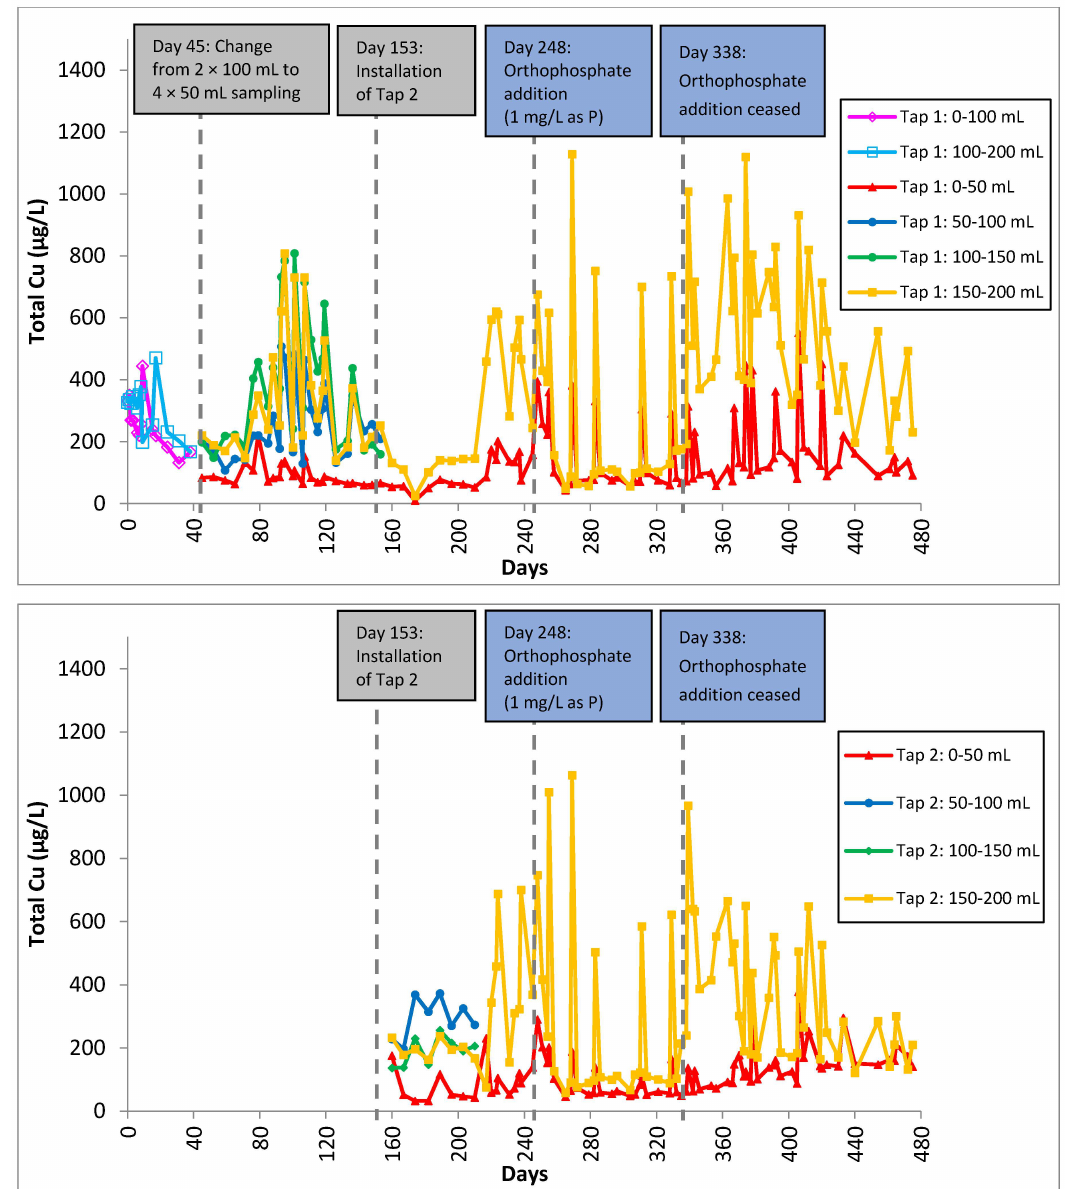
Figure 4. Total copper in Tap 1 ( top ) and Tap 2 ( bottom ) samples as a function of time for 475 days. A second tap was installed on Day 153 and orthophosphate was introduced on Day 248 and discontinued on Day